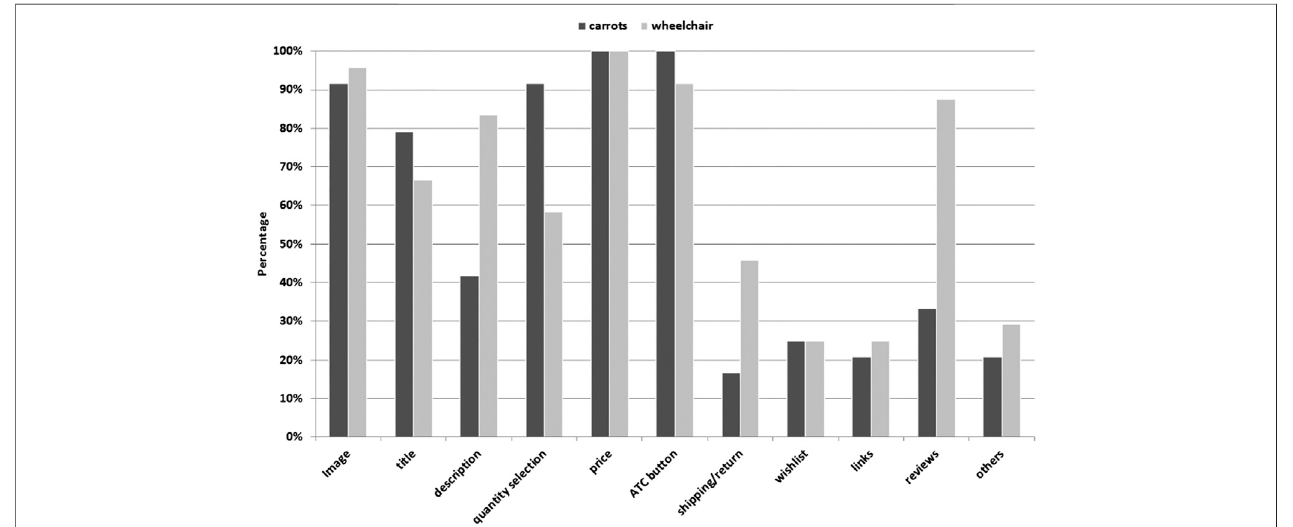
FIGURE 6 | Percentage of designed pages containing the various web